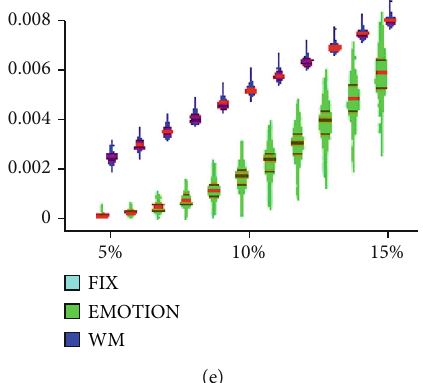
Figure 6: The ANOVA results of global property analysis for FIX, EMOTION, and WM: (a) assortativity; (b) global e ffi ciency; (c) transitivity; (d) global e ffi ciency graph enlarged for WM; (e) transitivity graph enlarged for EMOTION and WM at the threshold of 10%. WM: working